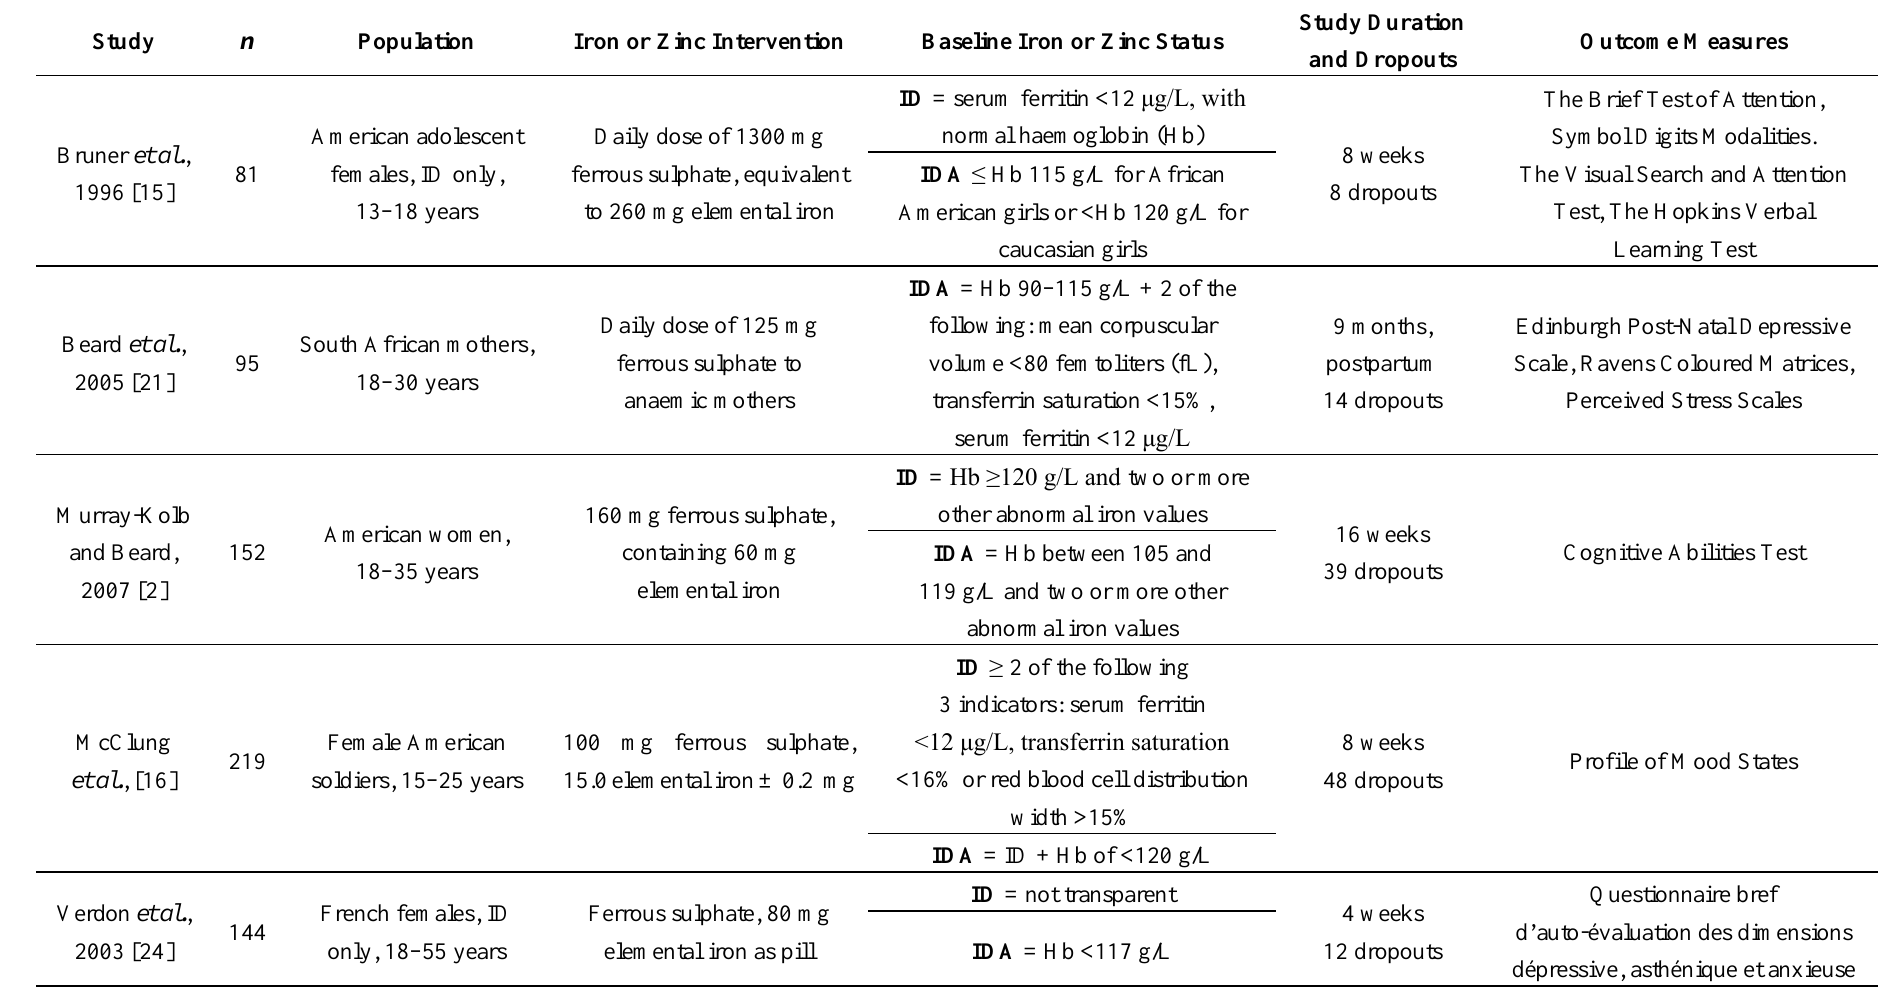
Table 1. Characteristic summary of the included studies ( N = 11). ID, iron